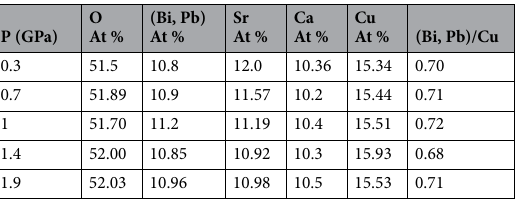
Table 1. EDX analysis of (Bi, Pb)-2223 superconductor compacted at different pressure.